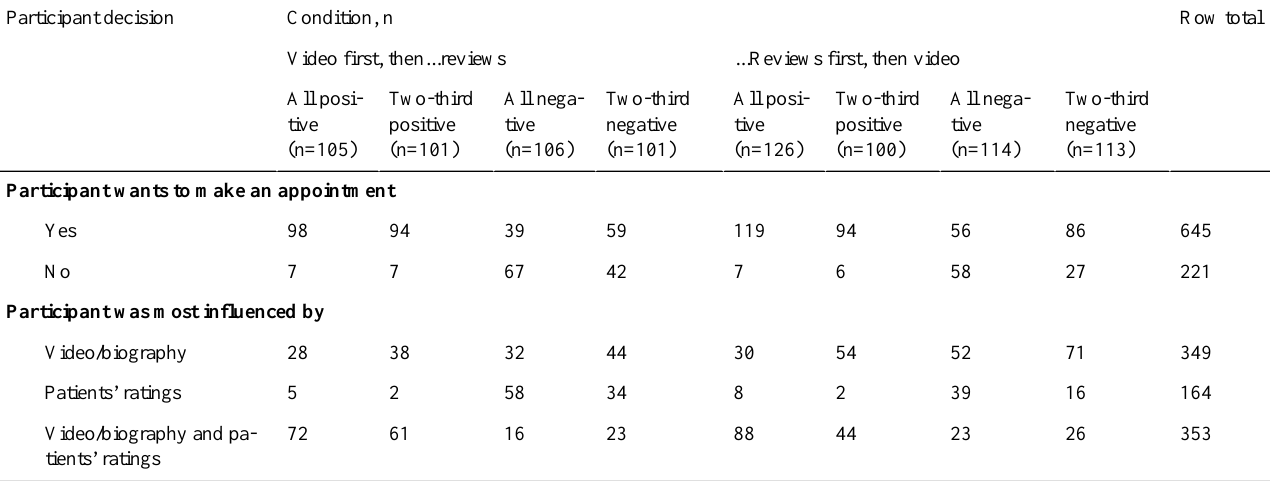
Table 3. Participants’decision making by condition.